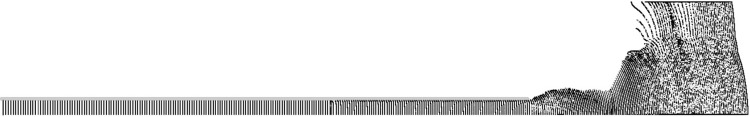
The planarity of the shock front is largely lost at the shock tube exit.The edge of the shock front at each time step (Δt = 38.5 μs) from t = 0–13.5 ms in the moderate strength shock in a mid-wall cut. As the shock exits the shock tube, denoted by a grey bar, the shock front loses its planar nature and expands, becoming non-planar.